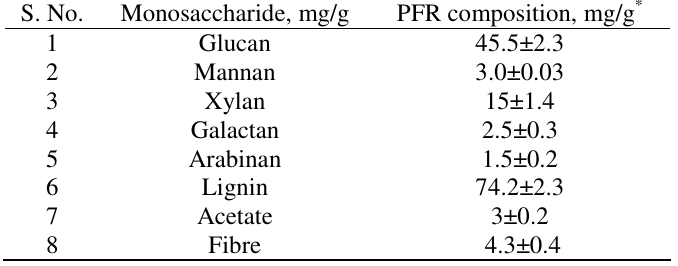
Table 1. Potential monosaccharide composition of paper fibre residues (PFR) S.